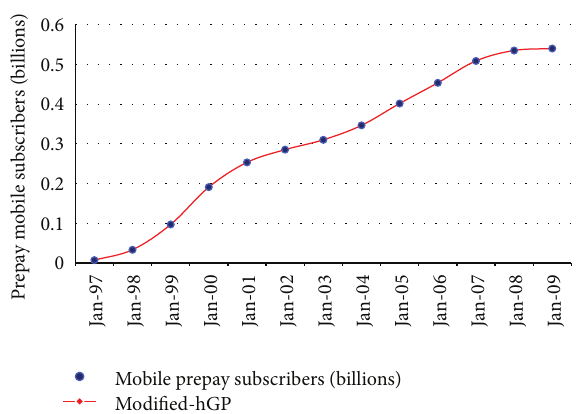
Figure 13: The fitting performance of the modified-hGP model for the OECD mobile contract subscribers.